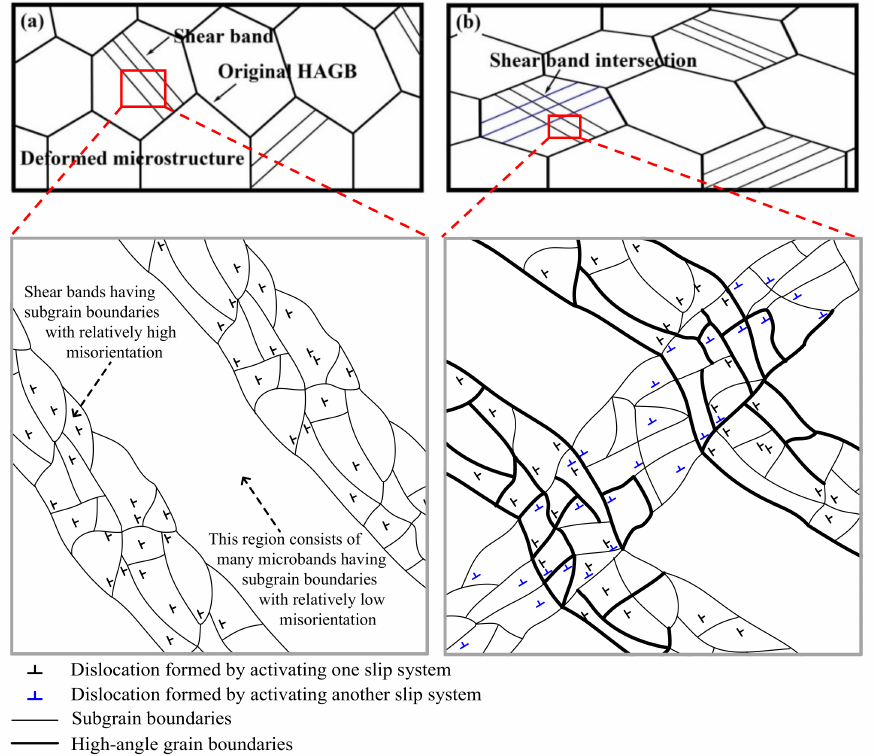
Figure 16. Schematic diagram showing the nucleation model of DRX formed along the in-grain shear band. ( a ) The formation of one set of shear bands. ( b ) The intersection of shear band and formation of new grains along the shear band. (Note that only dislocations of one sign are shown for one activated slip system in the schematic diagram for simplifying